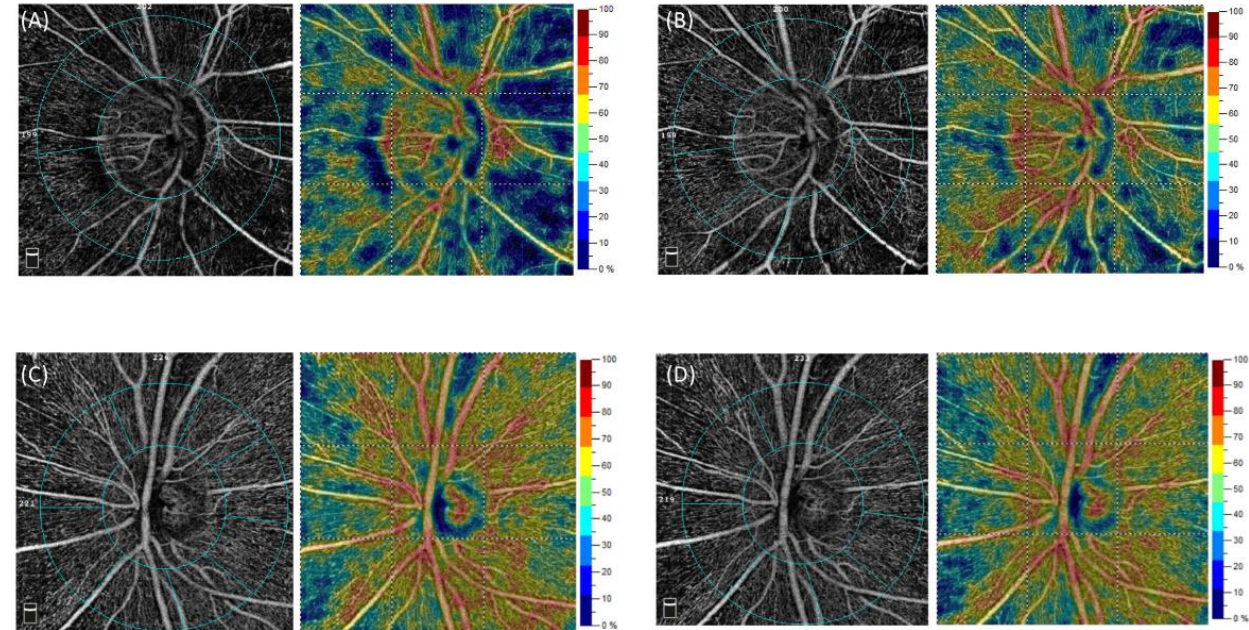
Figure 3. Representative cases of vessel density (VD) changes in patients with normal-tension glaucoma treated using carteolol. ( A ) Case 1, before carteolol treatment (peripapillary VD = 37.9%). ( B ) Case 1, VD increases after the 6-month topical carteolol treatment (peripapillary VD = 45.6%). ( C ) Case 2, before carteolol treatment (peripapillary VD = 55.4%). ( D ) Case 2, VD decreases after the 6-month topical carteolol treatment (peripapillary VD = 52.4%). Table 2. Significant independent variables related to the change percentage of peripapillary vessel density/signal strength index after 6-month carteolol treatment in normal-tension glaucoma patients.